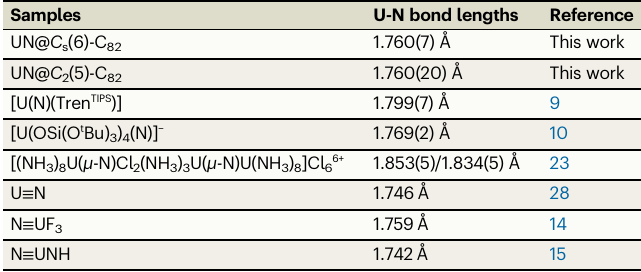
Table 1 | Crystal data of U ≡ N bond lengths and calculated